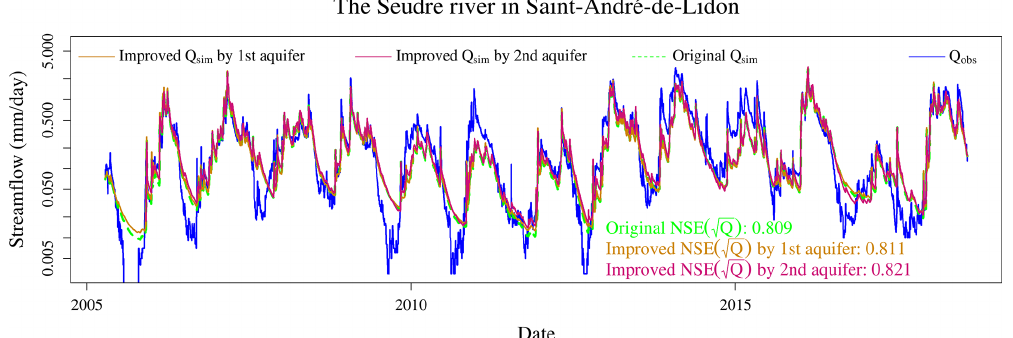
Figure 11. Observed and simulated streamflows of the Seudre River in Saint-André-de-Lidon, where the simulated streamflow was obtained with the original and the new calibration frameworks. A log scale is used to focus on low